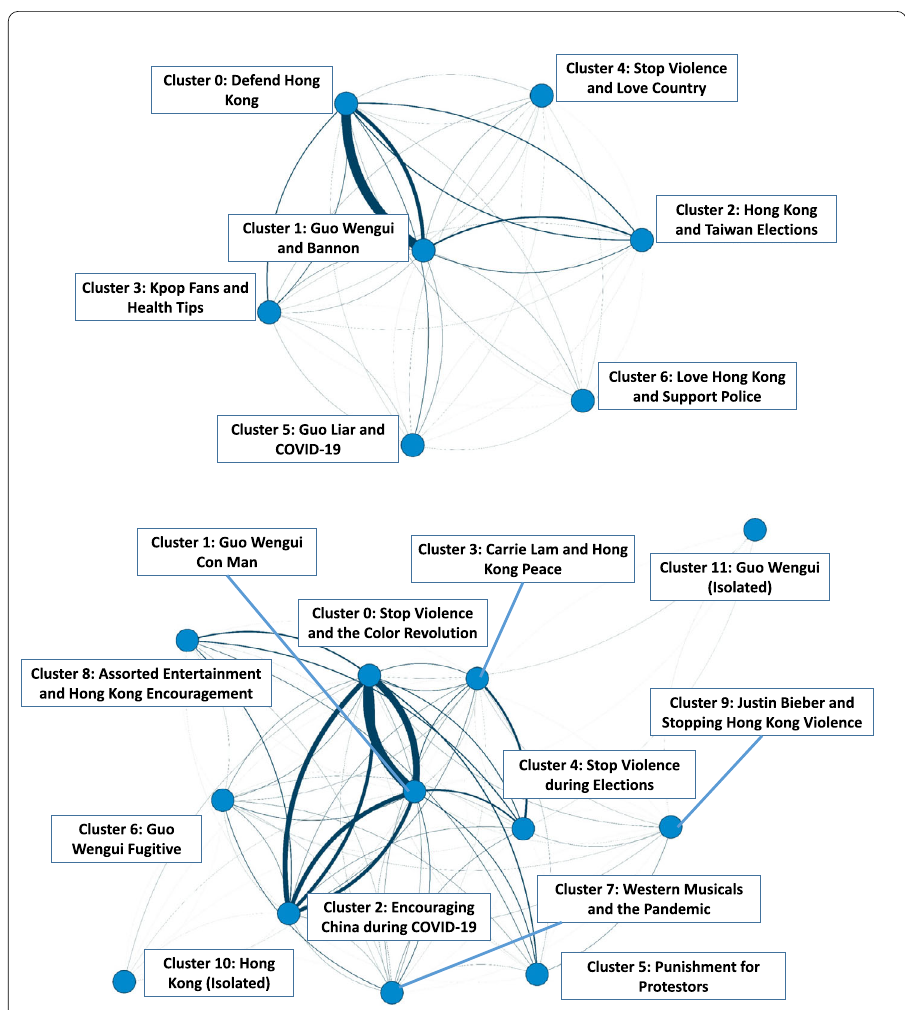
Figure 4 Organization of clusters of Chinese state-sponsored accounts, visualized on ORA. Nodes represent MVMC-derived clusters, connected by edges with thickness proportional to their weight. Top: Clustering obtained on accounts in Era 1. Bottom: Clustering obtained on accounts in Era 2